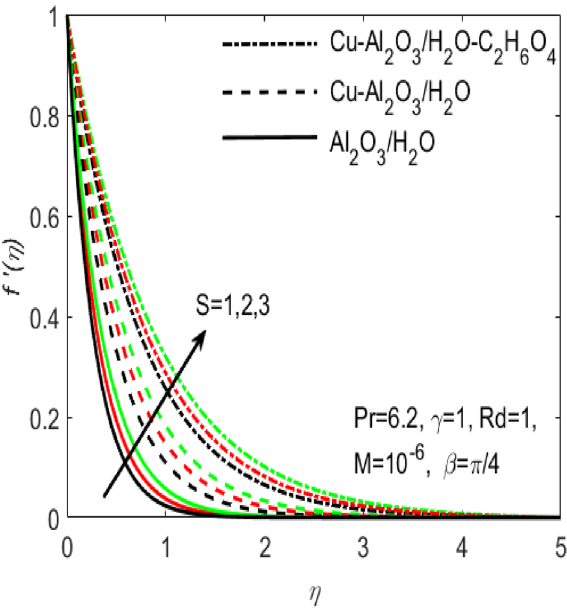
Figure 3. Influence of S on f ′ (η) for different hybrid nanofluids and simple